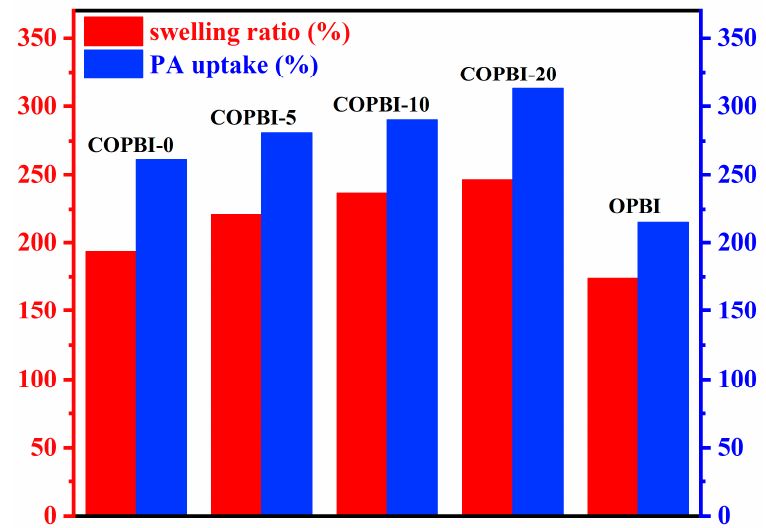
Figure 6. PA uptake and swelling ratio of OPBI and COPBI membranes.